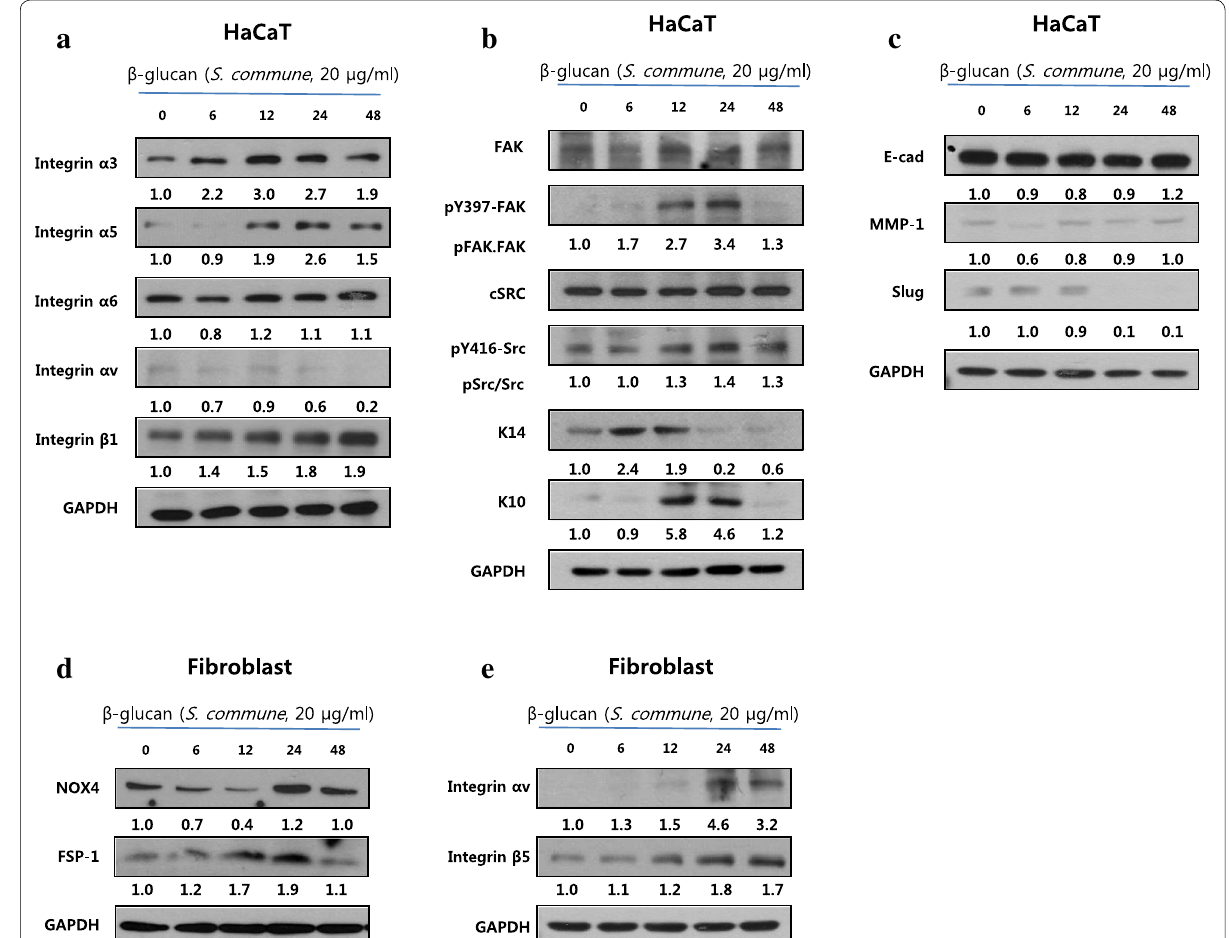
Fig. 4 The action mechanisms of beta-glucan ( S. commune ) on keratinocyte and fibroblat. a – c Western blotting for HaCaT cells treated with the S. commune beta-glucan in a time-dependent manner. Cell lysates were isolated using RIPA solution and protein concentration was measured by BCA assay. The expression levels were normalized to GAPDH. The values indicate intensities of protein expression with respect to that of the loading control. d , e Western blotting for HaCaT cells treated with the S. commune beta-glucan in a time-dependent manner. Cell lysates were isolated using RIPA solution and protein concentration was measured by BCA assay. The expression levels were normalized to GAPDH. The values indicate